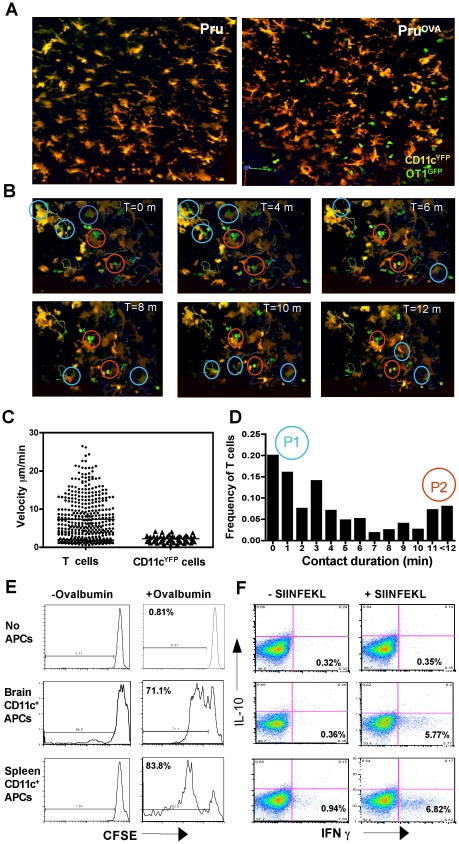
CNS resident CD11c+ cells are efficient antigen presenting cells.
A) Representative z stacks (30 µm) of brain slices from CD11cYFP mice that received OT1GFP cells and were infected with Pru (left) or PruOVA (right) 3 weeks prior. B) Representative time series showing short term (blue circles) and sustained (red circles) interactions between OT1GFP and CD11cYFP cells. C) The average migration velocities of OT1GFP T cells and CD11cYFP obtained by manual tracking using Volocity. D) The frequency of OT1GFP cells interacting with CD11cYFP cells and the duration of these interactions is shown on the y-axis. The imaging sessions typically lasted between 12–15 minutes. E) CFSE dilution profile of naïve OT1 cells that were co-cultured (3 days) with CD11c+ cells purified from either spleen or brain (of chronically infected mice). F) The ability of the proliferated cells to produce the cytokines IFN-γ and IL-10, during re-stimulation (6 hours) in vitro in the presence of brefeldin-A, with/without antigenic peptide (SIINFEKL).